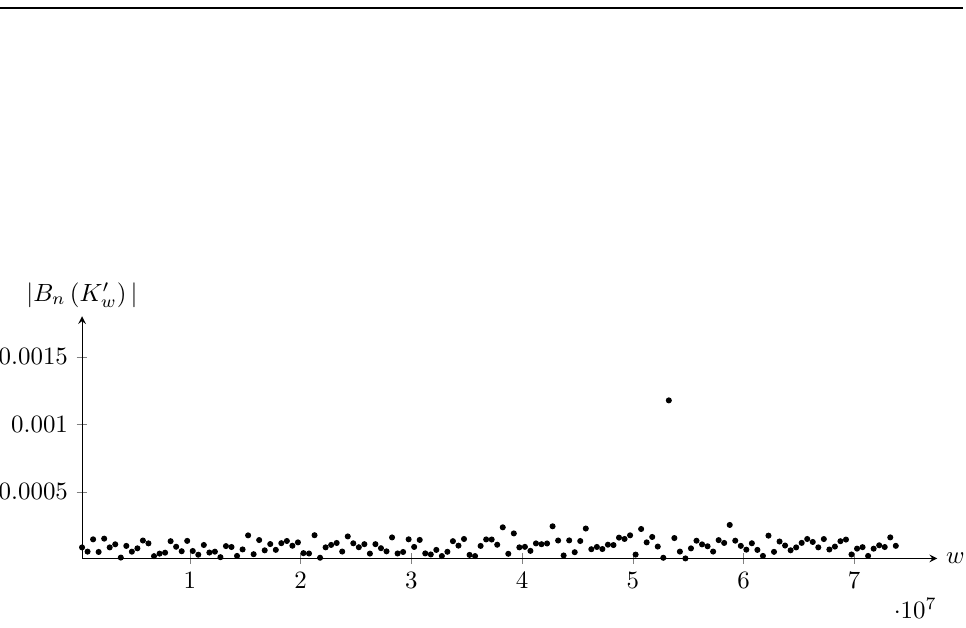
Figure 9: Detected sampled biases after reducing the signatures with 2-bit biased